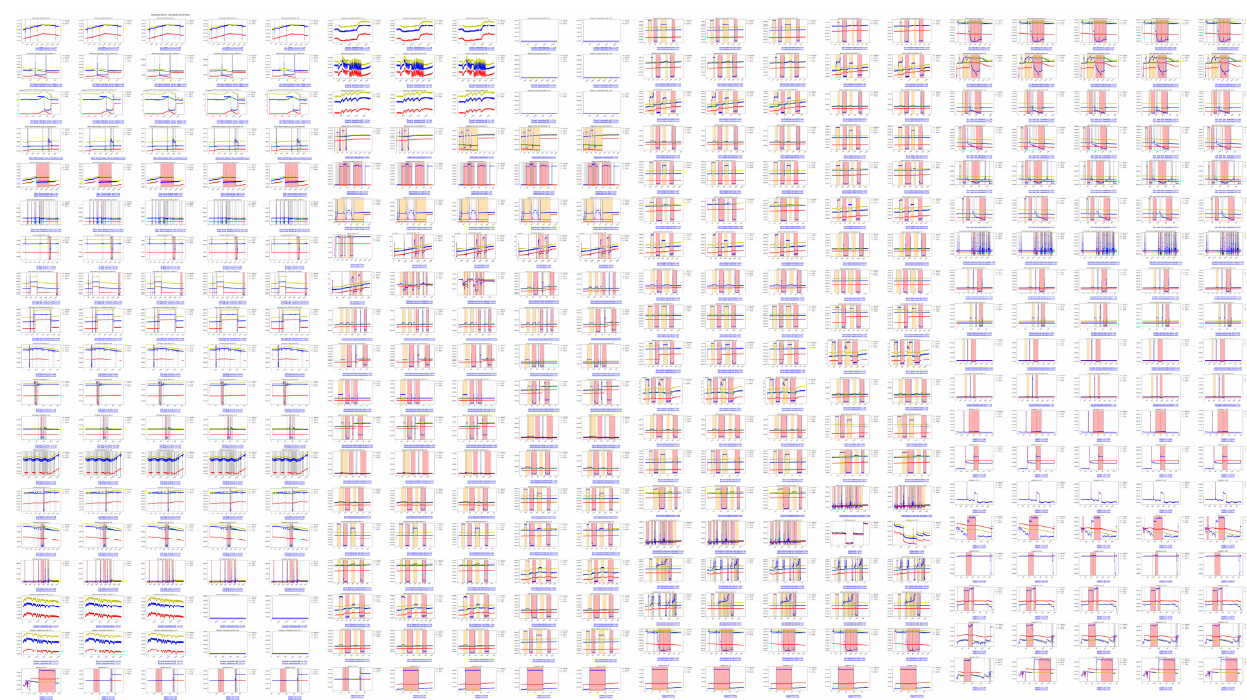
Figure 27. Overview of the CEMF sensor validation’s library.